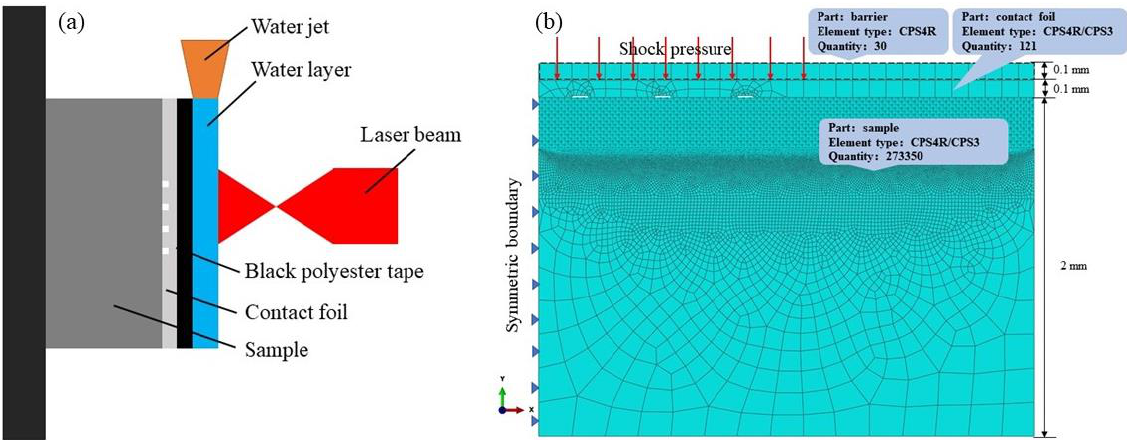
Figure 1. LSI schematic ( a ) and finite element model ( b ).